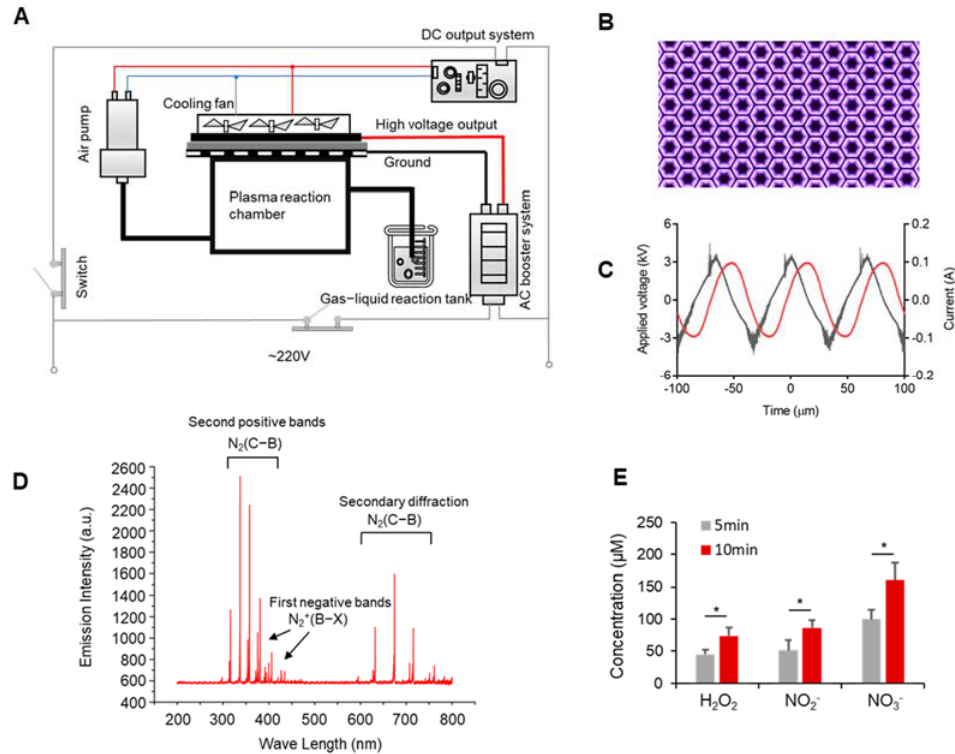
Figure 1. Development of the portable plasma device and detection of the discharge characteristics. ( A ) Schematic diagram of the DBD plasma device. ( B ) Plasma discharge photo. ( C ) Waveforms of the applied voltage and discharge current. ( D ) Plasma spectral emission intensity of the DBD plasma device. ( E ) The concentration of long-lived particles. Data represent the mean ± SD; n = 3; * p < 0.05.